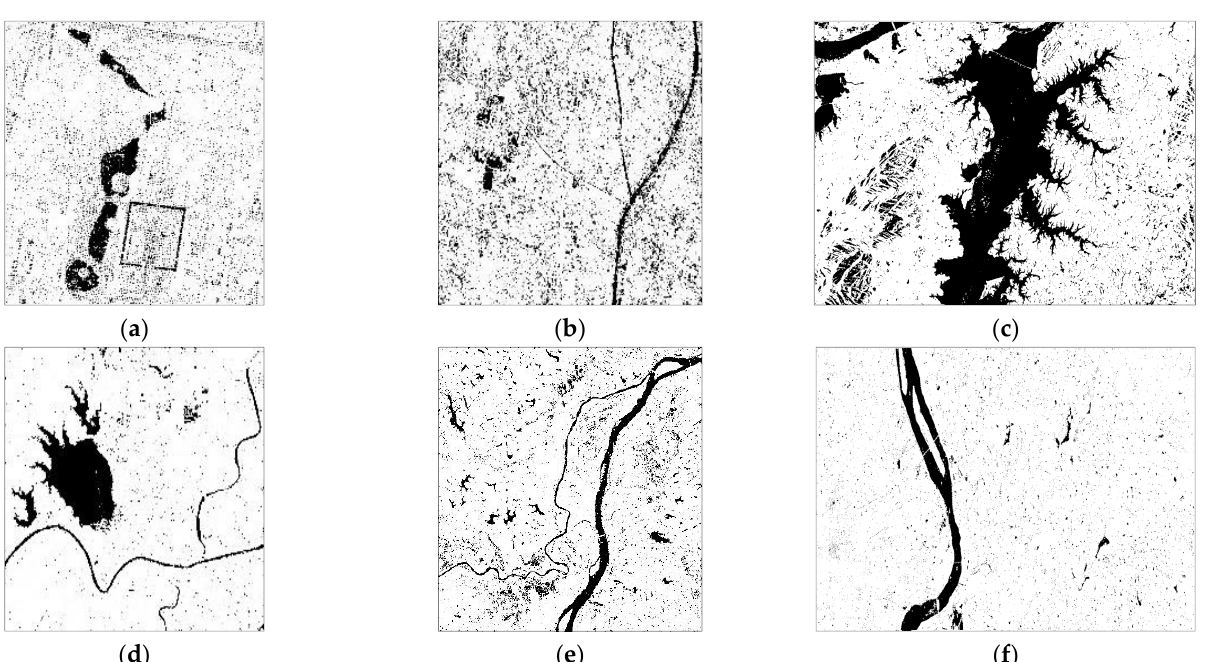
Figure 5. ( a – f ) are the initial segmentation results from Data A to Data F. The black and white pixels indicate water and non-water, respectively.